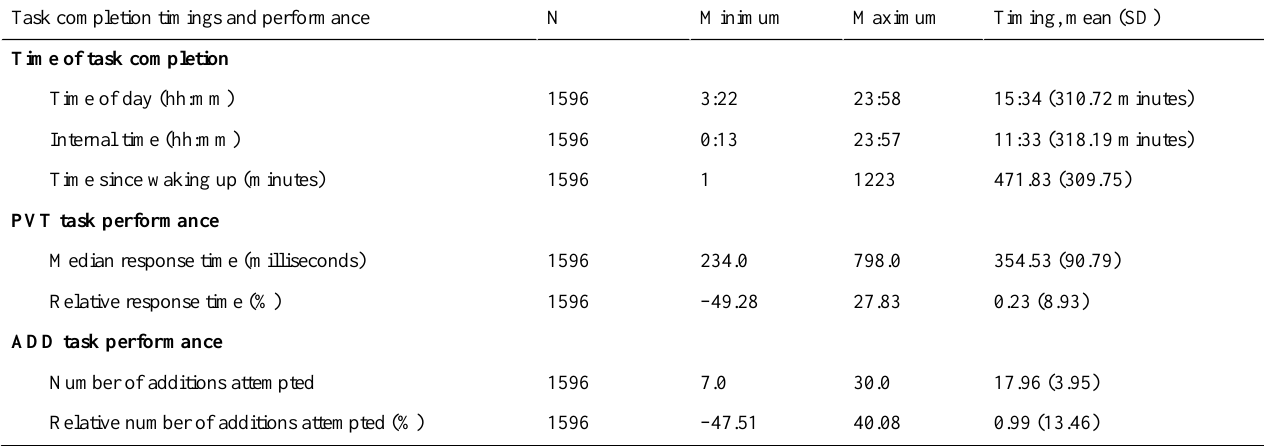
Table 1. Distribution of task completion timings and performance on PVT a and ADD b